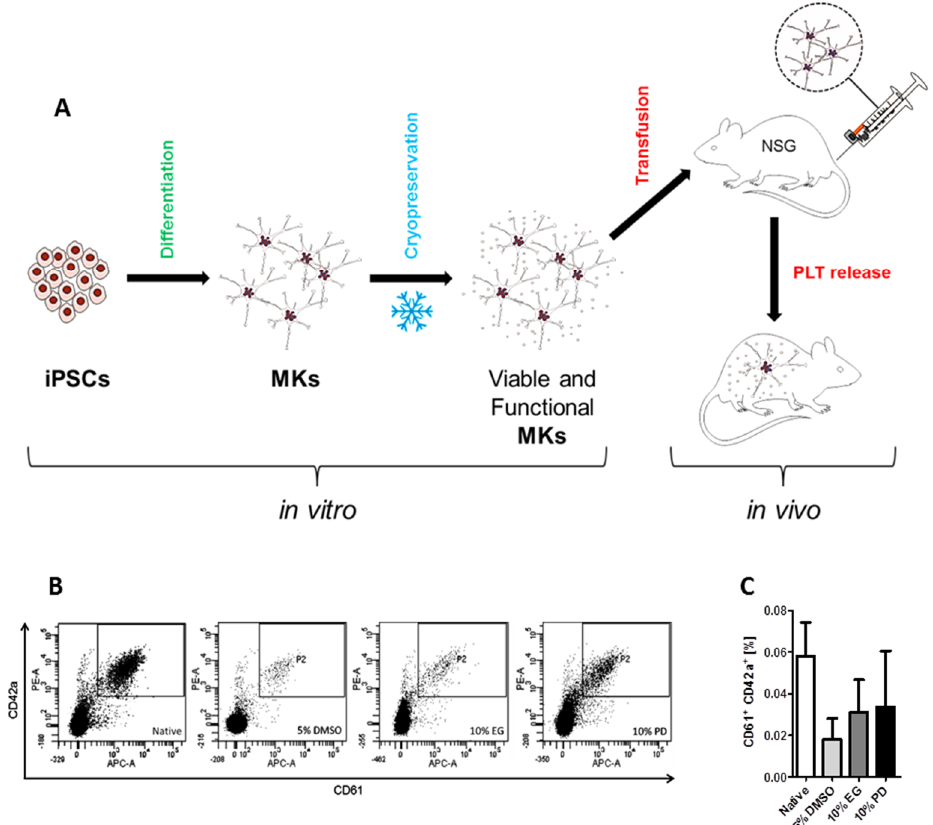
Figure 9. Cryopreserved in vitro iPSC-derived MKs produce PLTs after transfusion into a mouse model. Mice were transfused with 3 × 10 6 iPSC-derived MKs before and after cryopreservation by tail vein injection. Frequencies of human PLTs were detected 1 h after MK infusion by flow cytometry analysis of the peripheral blood of mice. ( A ) Schematic representation of the experiment: in vitro—differentiation of iPSCs into mature MKs, cryopreservation, recovery of viable and functional MKs after cryopreservation; in vivo—transfusion into mouse model, PLT production in the blood stream. ( B ) Representative dot plots of the flow cytometric analysis of population of human PLTs released to the blood stream of a mouse 1 h after transfusion of cryopreserved and native MKs. ( C ) The graph shows frequencies of the human PLTs detected after MK transfusion in three independent experiments for each sample presented as mean ± SD, n = 3.